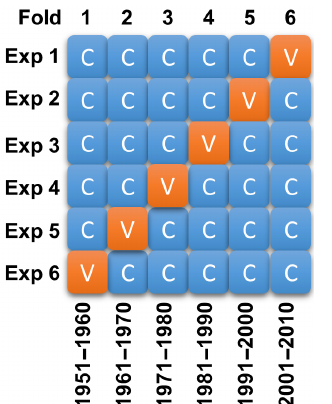
Figure 4. The 6-fold cross validation scheme with the calibration (C) and the validation (V) periods of each fold. Each experiment (Exp) was replicated for all five